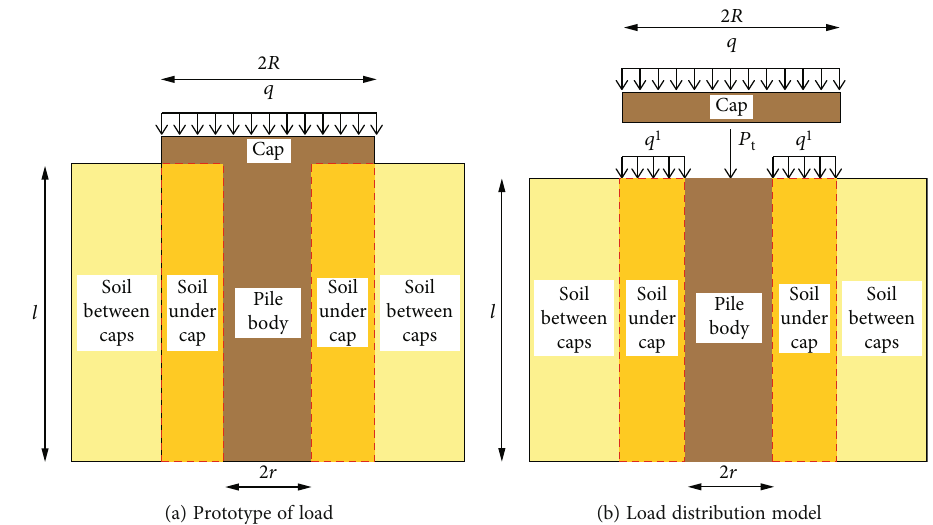
Figure 1: Mechanical model of capped pile.